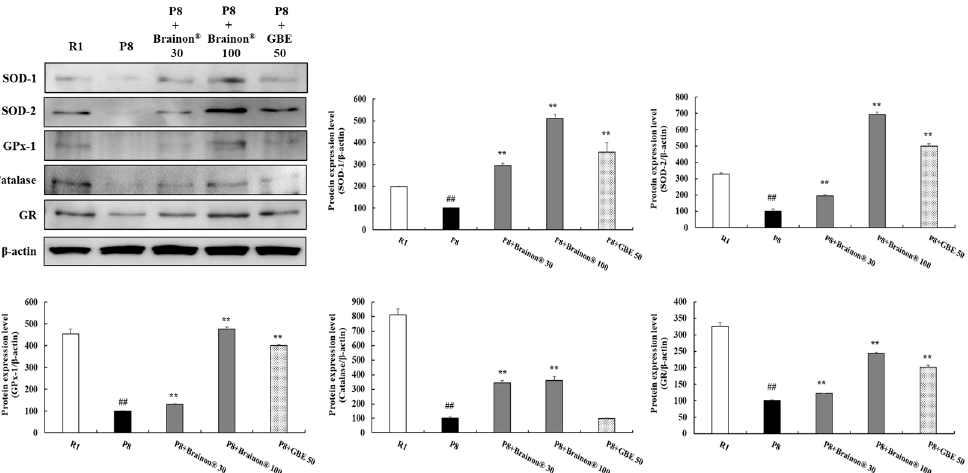
Figure 6. Brainon ® promotes antioxidant enzymes in the cerebral cortex of SAMP8 mice. SOD-1 (23 kDa), SOD-2 (25 kDa), GPx-1 (23 kDa), catalase (60 kDa), and GR (50–65 kDa) protein levels were analyzed utilizing Western blotting. Density of each protein band was measured using the ImageJ program. Protein was normalized with β -actin (45 kDa). Values are presented as mean ± SD ( n = 3). ## p < 0.01 vs. R1 (SAMR1) group; ** p < 0.01 vs. P8 (SAMP8) group.